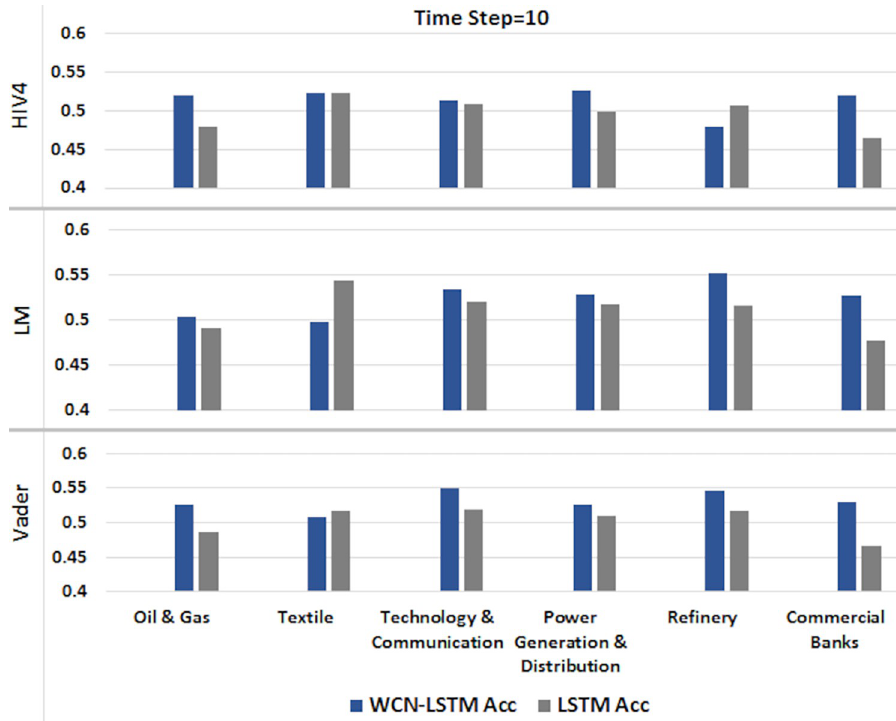
Fig 12. Comparison among sectors for time step = 10. https://doi.org/10.1371/journal.pone.0282234.g012 PLOS ONE | https://doi.org/10.1371/journal.pone.0282234 March 7,